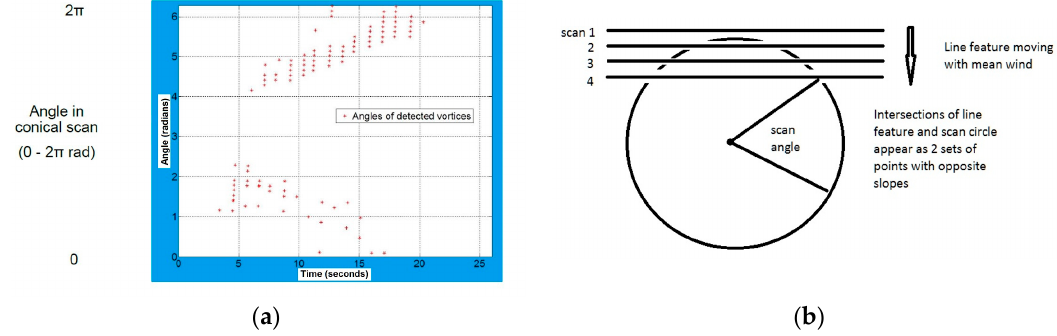
Figure 9. A passing aircraft leaves a pair of trailing wake vortices which form (briefly and approximately) a stable “line feature” in the atmosphere. This line drifts with the mean wind across the scan circle defined by the measurement points of a conical-scan lidar, and the angles where the lidar detects a significant disturbance are recorded and plotted. ( a ) Example of data from trials with ZephIR at Birmingham airport, adapted from Hill et al. [33]; ( b ) Sketch of the principle. This plan view is simplified; in practice the lidar processing and scanning may take account of vertical as well as horizontal drifts and may have complicated algorithms for estimating the vortex and wind parameters.